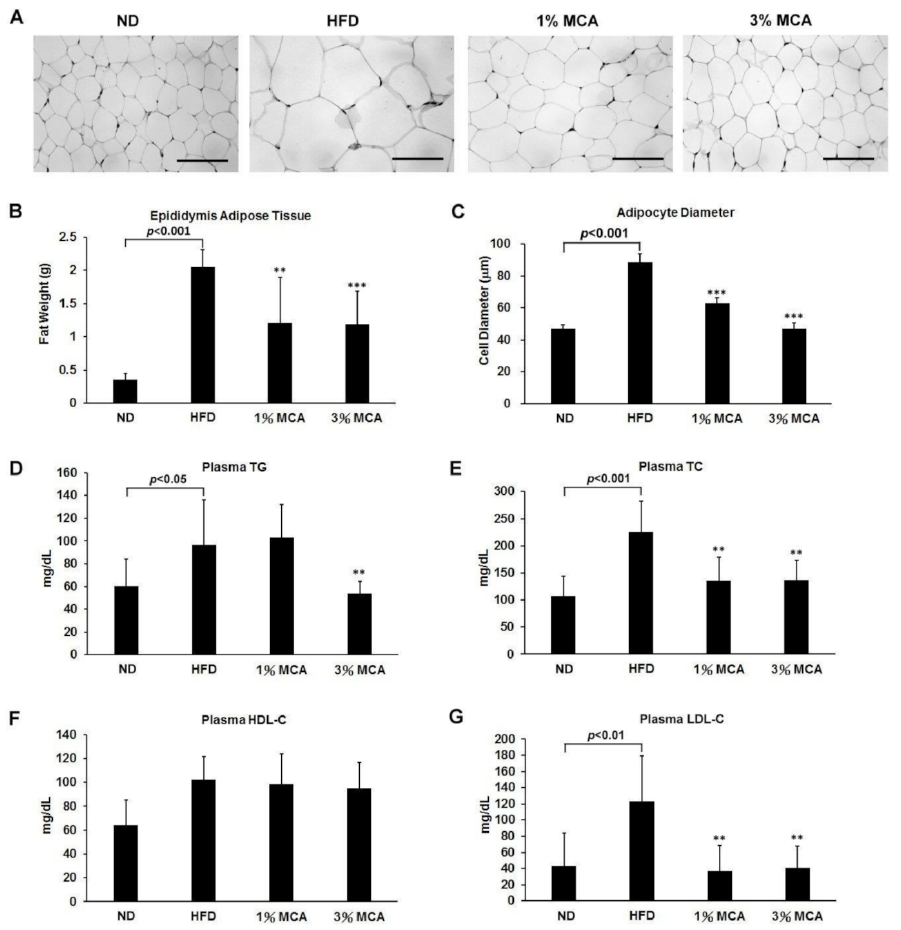
Figure 2. The effect of MCA on fat deposition and plasma lipid levels in HFD-fed mice. ( A ) Hema- toxylin and eosin staining showed adipocytes in epididymis adipose tissues (EAT). ( B ) The weight of EAT. ( C ) The adipocytes diameters. ( D ) Plasma triglyceride (TG). ( E ) Total cholesterol (TC). ( F ) high- density lipoprotein-cholesterol (HDL-C). ( G ) Low-density lipoprotein-cholesterol (LDL-C). The scale bar is 100 µ m. Data are shown as means ± SEM. HFD vs. MCA, ** p < 0.01; *** p <